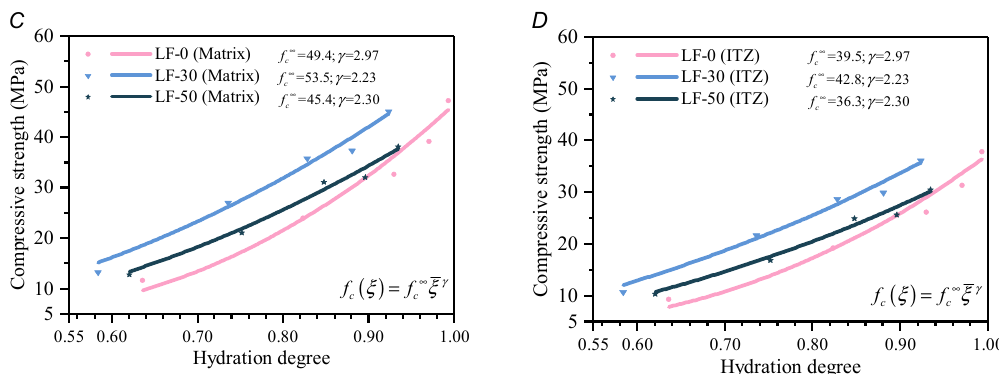
Figure 8. The elastic modulus and compressive strength evolution process in each phase of LF-0, LF-30, and LF-50. Elastic modulus evolution process: ( A ) matrix; ( B ) ITZ. Compressive strength evolution process: ( C ) matrix; ( D ) ITZ.